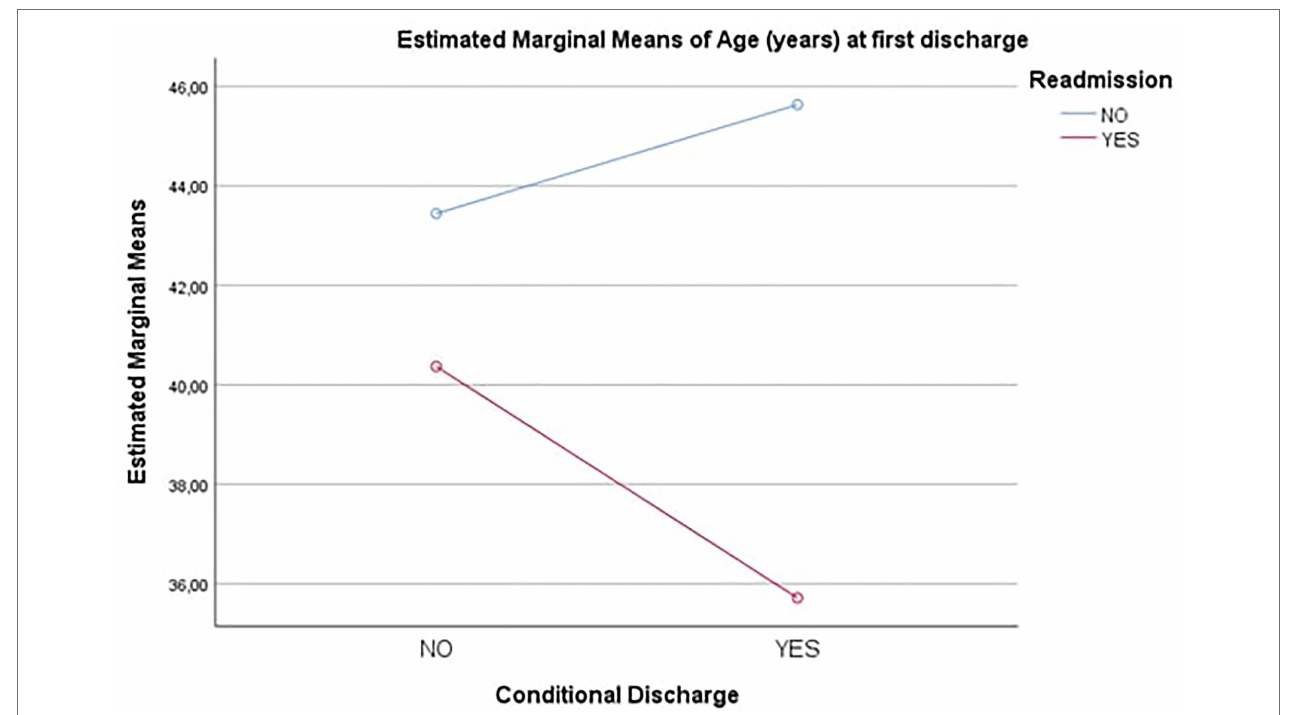
FIGURE 4 | Estimated marginal means – Age (years) at first discharge. Conditional Discharge = Conditional Release.